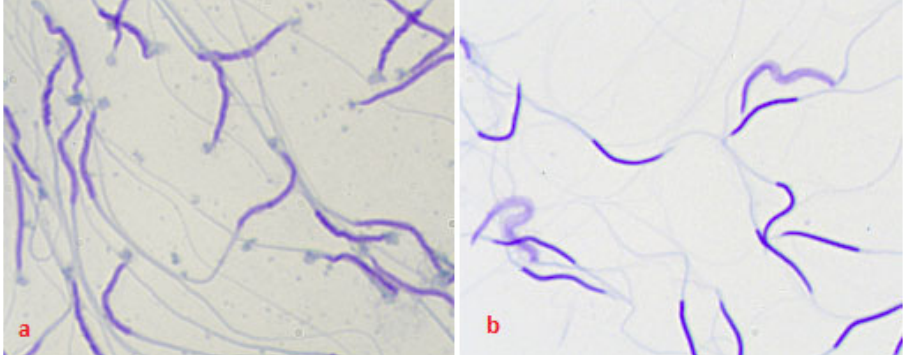
Figure 1. Damage to the integrity of chromatin (TBA) of spermatozoa under the influence of technological factors in the freezing protocol ( a ) thawed spermatozoa, LCM control, ( b ) thawed centrifuged spermatozoa. Classification: spermatozoa stained light blue were considered to have normal chromatin and the spermatozoa stained dark blue to violet were considered to have abnormal chromatin.